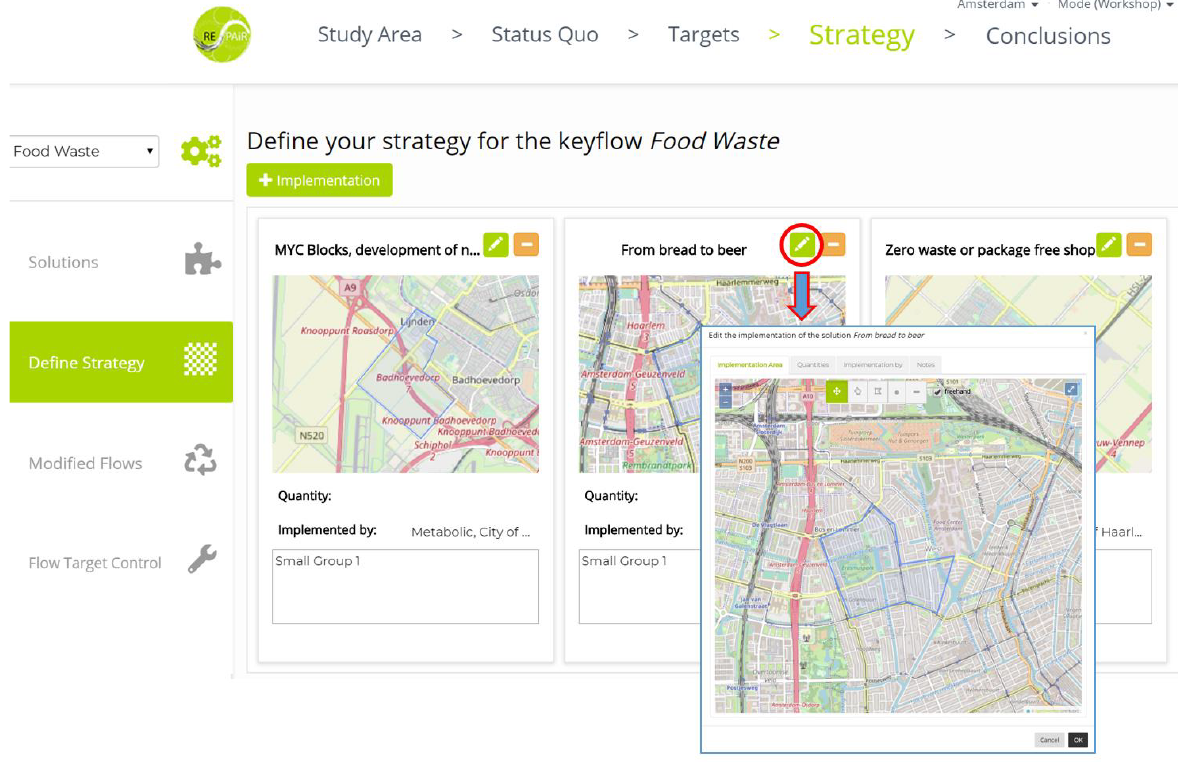
Figure 14. GDSE screenshot showing a strategy for key flow “food waste”, which is composed of three solutions, each with their own area of application and list of actors implementing them. Any solution in the strategy can be edited in a separate pop-up window (e.g., EIS “from bread to beer” in the strategy shown here).